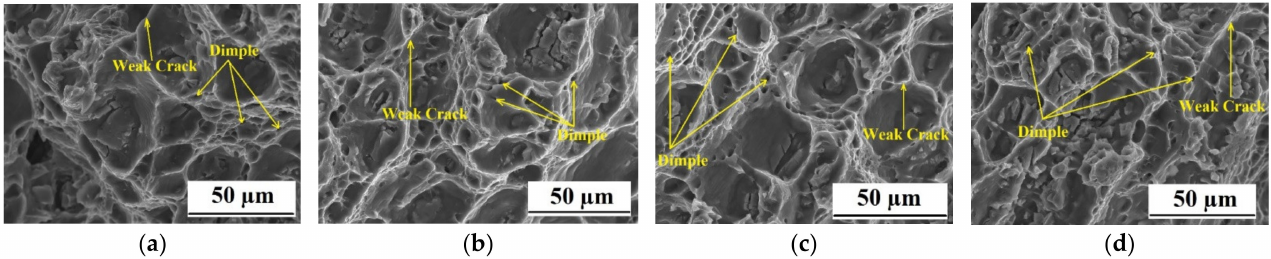
Figure 9. The 250 ◦ C temperature tensile fracture surfaces of the sample after surface of the 5083 alloy of ( a ) annealed and ECAP after ( b ) 1st pass ( c ) 2nd pass, and ( d ) 3rd